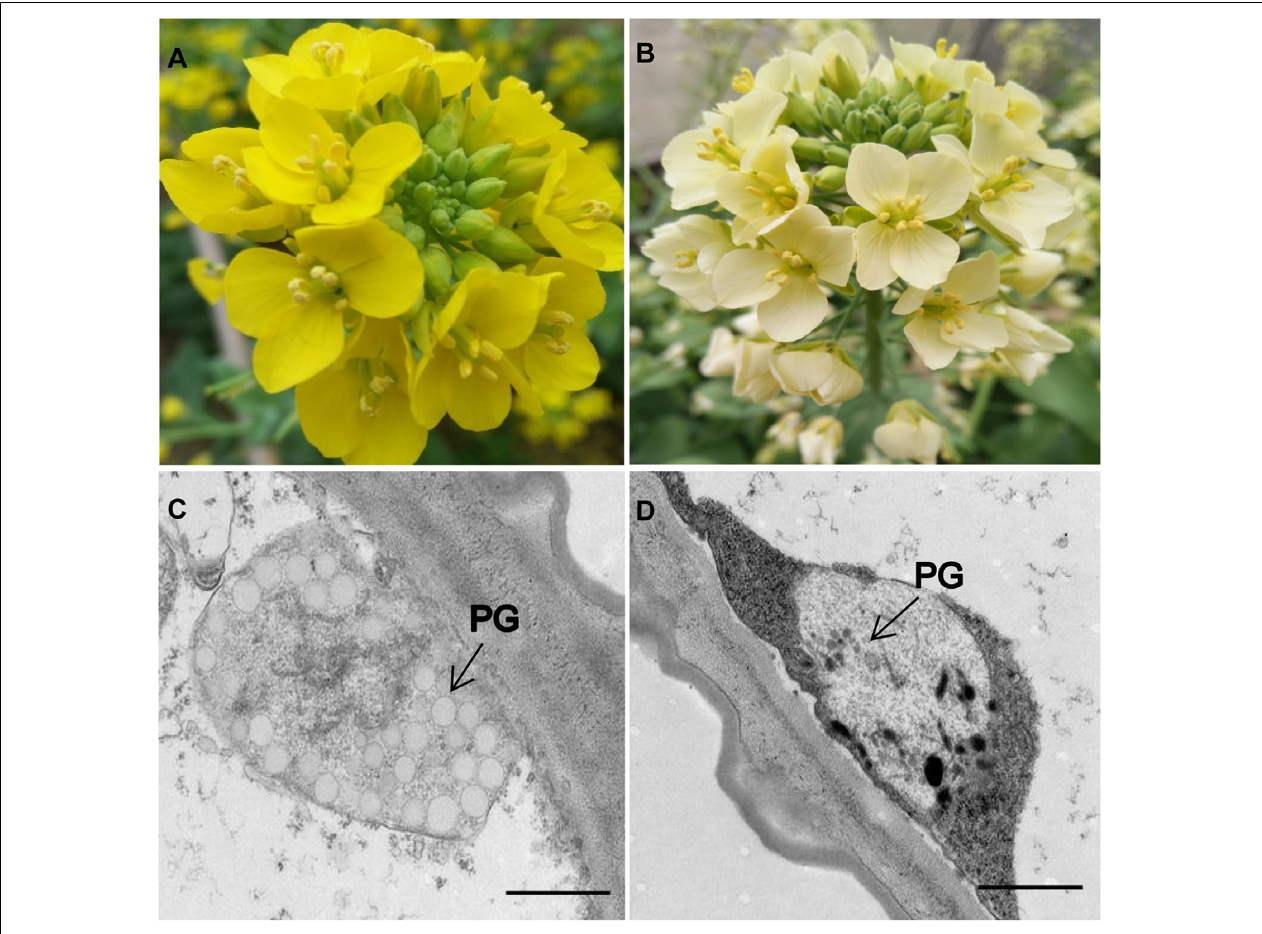
FIGURE 1 | Flower coloration and chromoplast ultrastructure in the parental lines. (A) Yellow-flowered Y641-87. (B) White-flowered Y640-288. (C,D) Plastid ultrastructure in Y641-87 and Y640-288. PG, plastoglobule; Scale bar, 1 µ m in (C,D) .